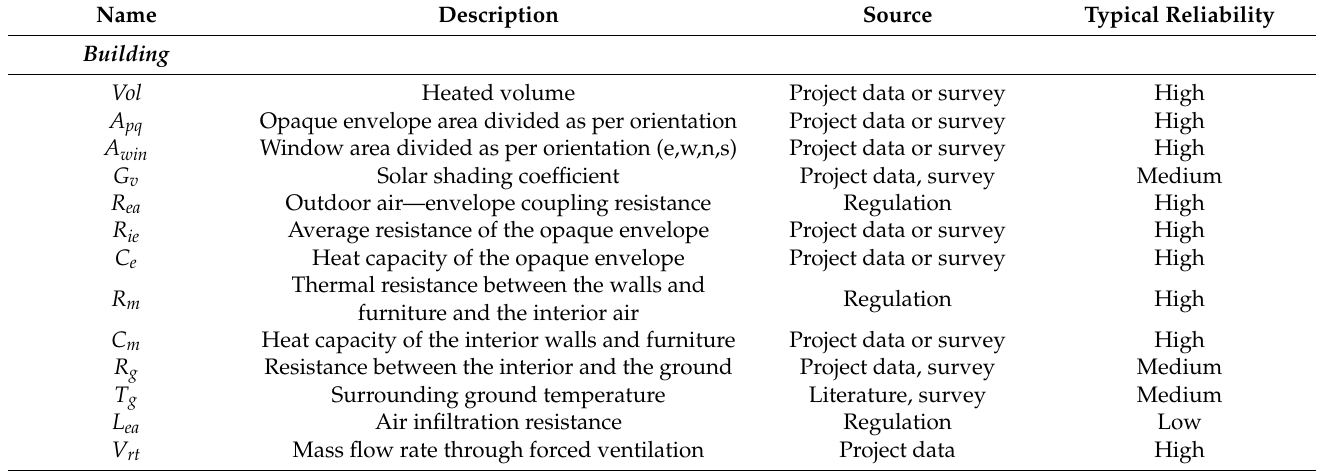
Table 1. The parameter set of the reduced energy